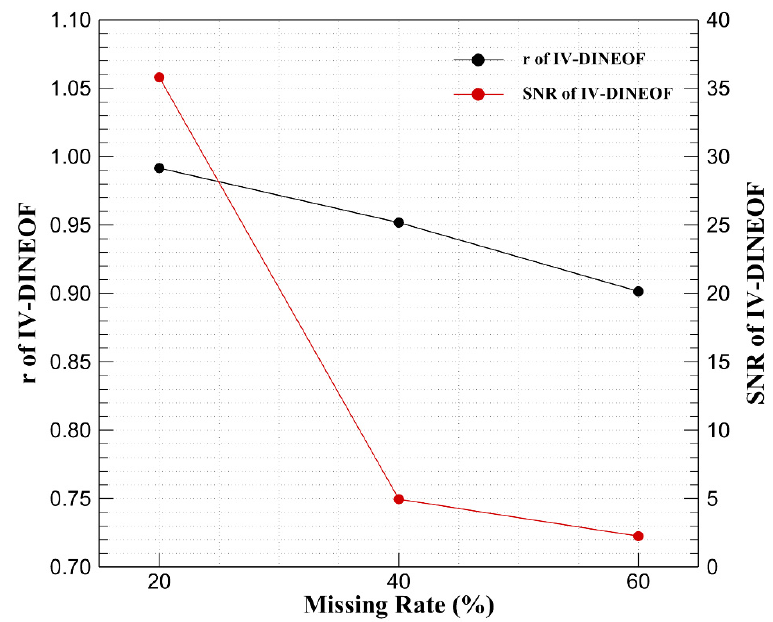
Figure 4. r and SNR of IV − DINEOF with different missing rates.